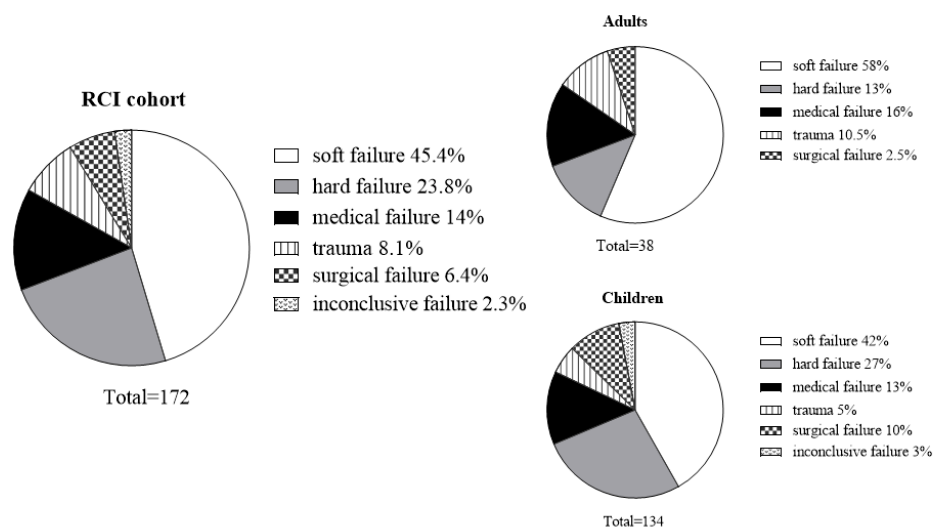
Figure 3. The distribution of revision cochlear implant (RCI) indications in all cases and divided by adults vs. children.